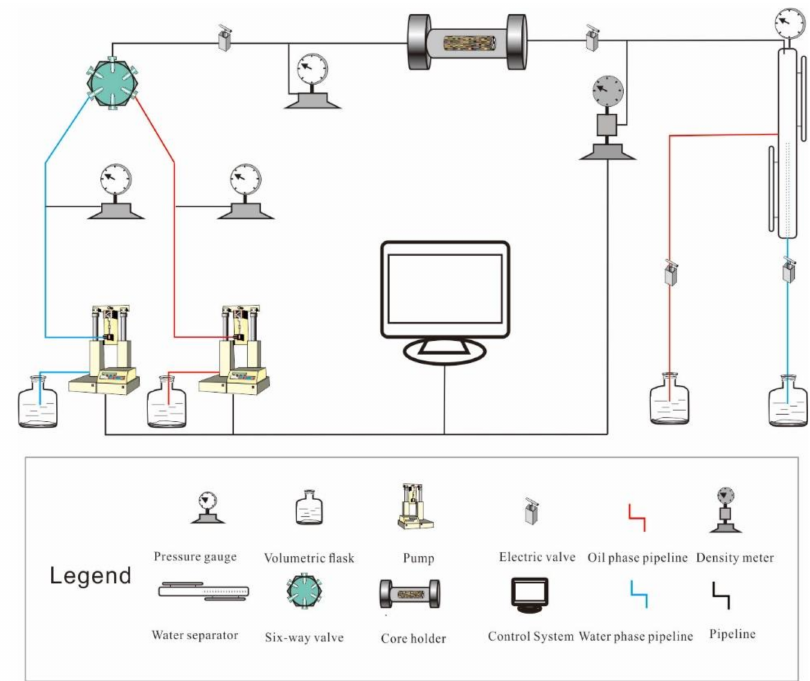
Figure 4. Experimental flowchart (the wetting phase and the non-wetting phase are injected into the core through a pump. The flow rates at the inlet and outlet ends of the core are measured and transmit the measurement data to the control